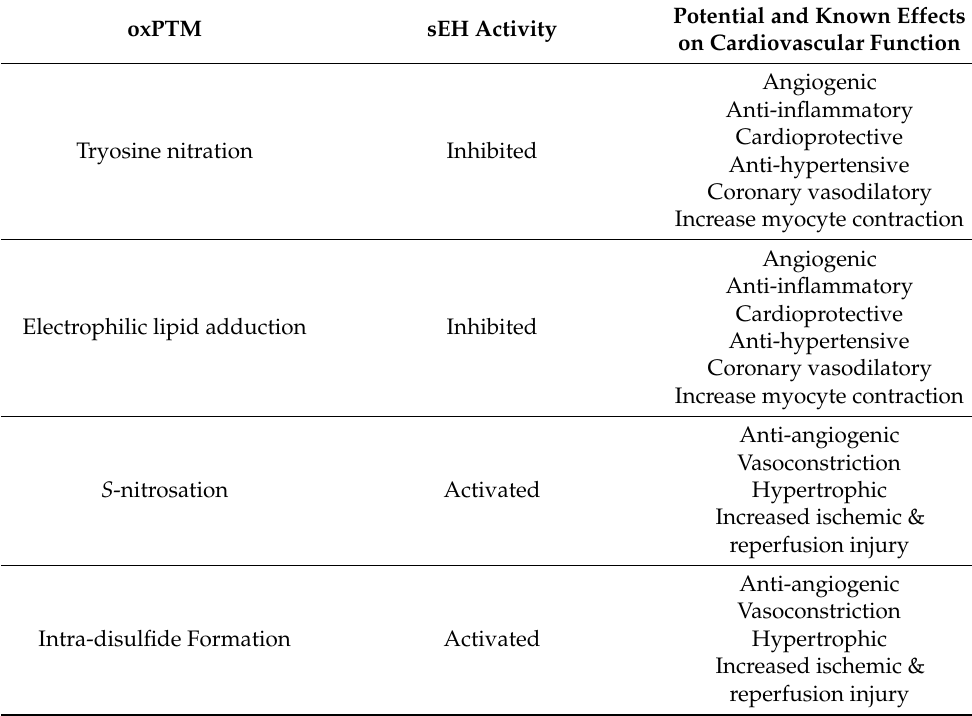
Table 1. Summary of different oxPTM that modulate sEH activity and their influences on cardiovas- cular health and disease. oxPTM sEH Activity